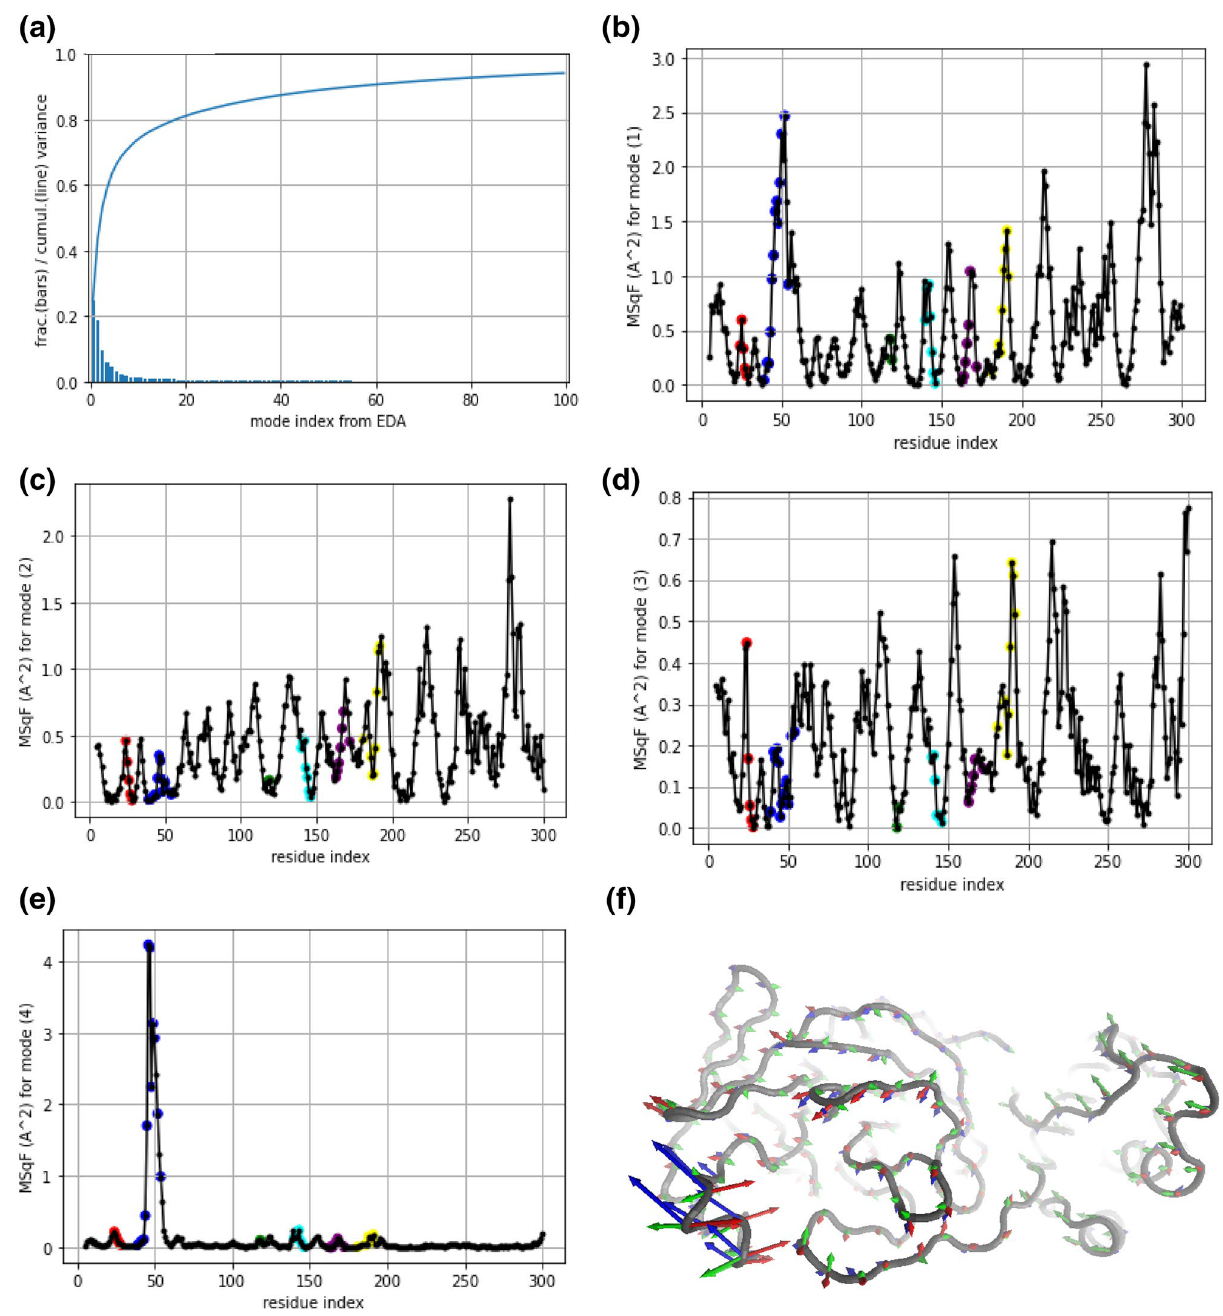
Figure 7. ( a ) EDA variance of the atomic fluctuation in the combined ensemble. Fractional variance (blue bars) and cumulative fractional variance (blue curve) of the atomic fluctuations for the first 100 PC modes from an EDA over the Grand ensemble of MD conformations. ( b – e ) Mobility profile per mode in the combined ensemble. Dissection of the MSqF (in Å 2 ) for the first 4 PC modes. Highlighted with colors residues belonging to active-site loops according to segment [24–28] (red), L3: [39–54] (blue), segment [118–119] (green), L1: [140–146] (cyan), “L” strand: [163–172] (purple), L2: [181–192] (yellow). ( f ) MD Grand ensemble deformations into the essential space. Tube representation of the Cα-trace of M pro (residues 5..300) depicting vectors that characterize the direction and relative magnitude of the deformations determined by the indicated PC modes: PC1 (blue), PC2 (red), and PC3 (green). Each set of vectors scaled to 1 Å of (cid:31) RMSF (cid:30) for visualization. The molecular graphic used in this figure was generated using ProDY 74 and rendered using VMD 1.9.3 63 ( f ) while the plots were created using Microsoft Excel 365 ( a – e ) (https:// www. office.